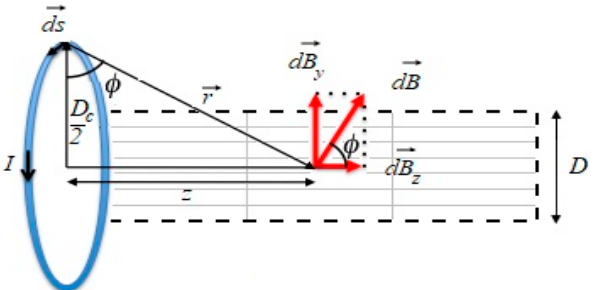
Figure 2. Schematic view of the approach to Biot–Savart’s law computation (own drawing based on the idea from [22]).